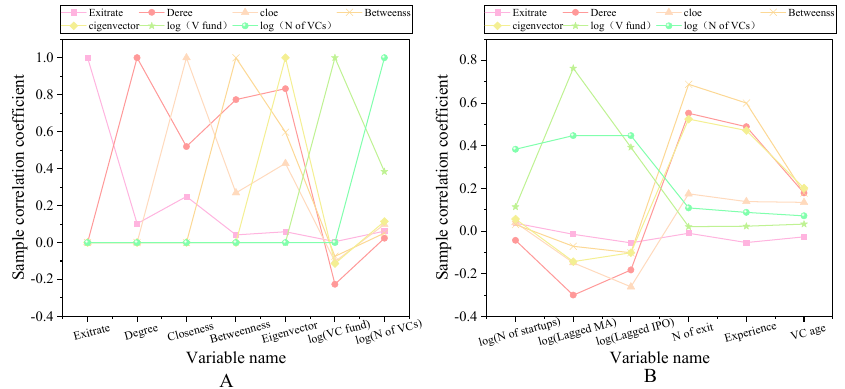
Figure 6. Correlation coefficient diagram of main variables ( A ) First seven variables. ( B ) Other variables.